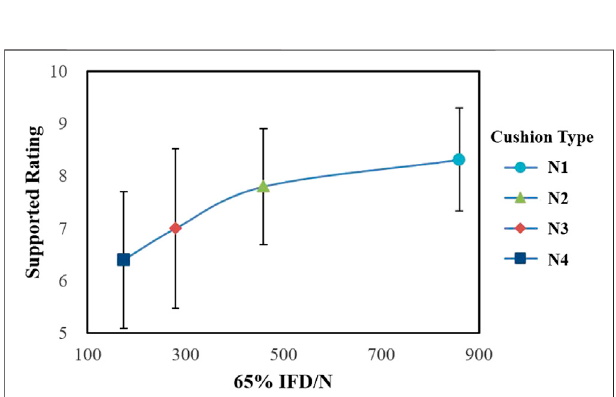
FIGURE 5 | Sup R increases with the increase in 65% IFD.